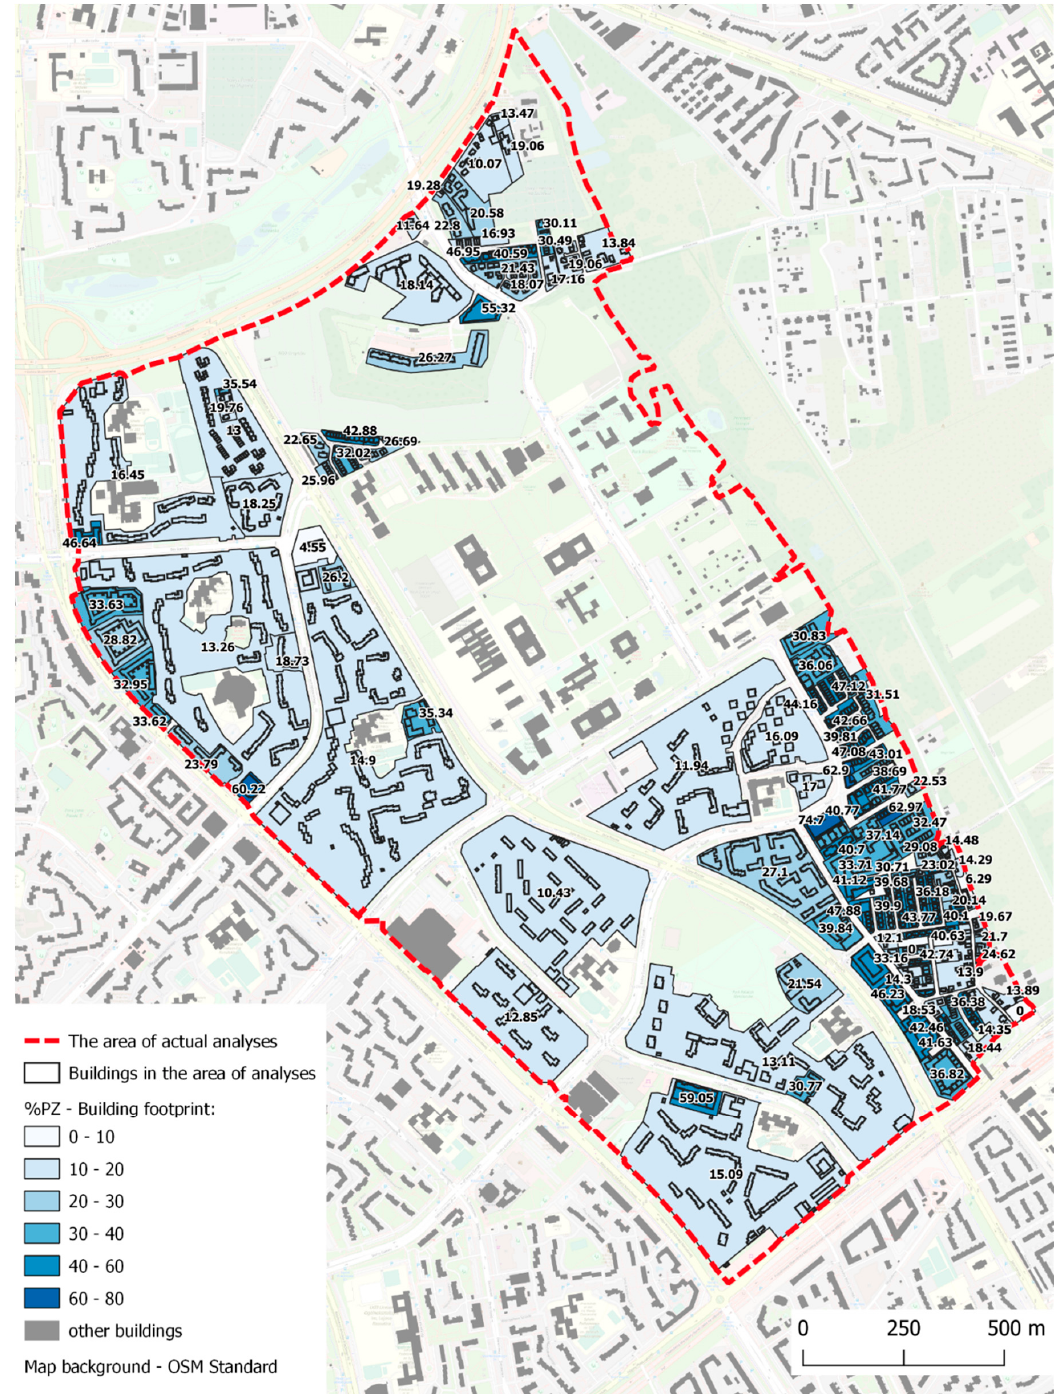
Figure A1. Building Footprint-%PZ.